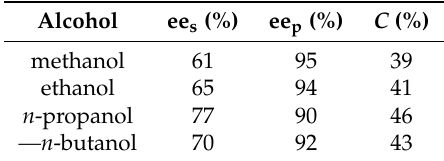
Table5. E ff ect of alcohol onthe parameters of kinetic resolution of ( R , S )-flurbiprofen.CALB immobilized on IB-S861 after 94 h (in DCM) of incubation. Alcohol ee s